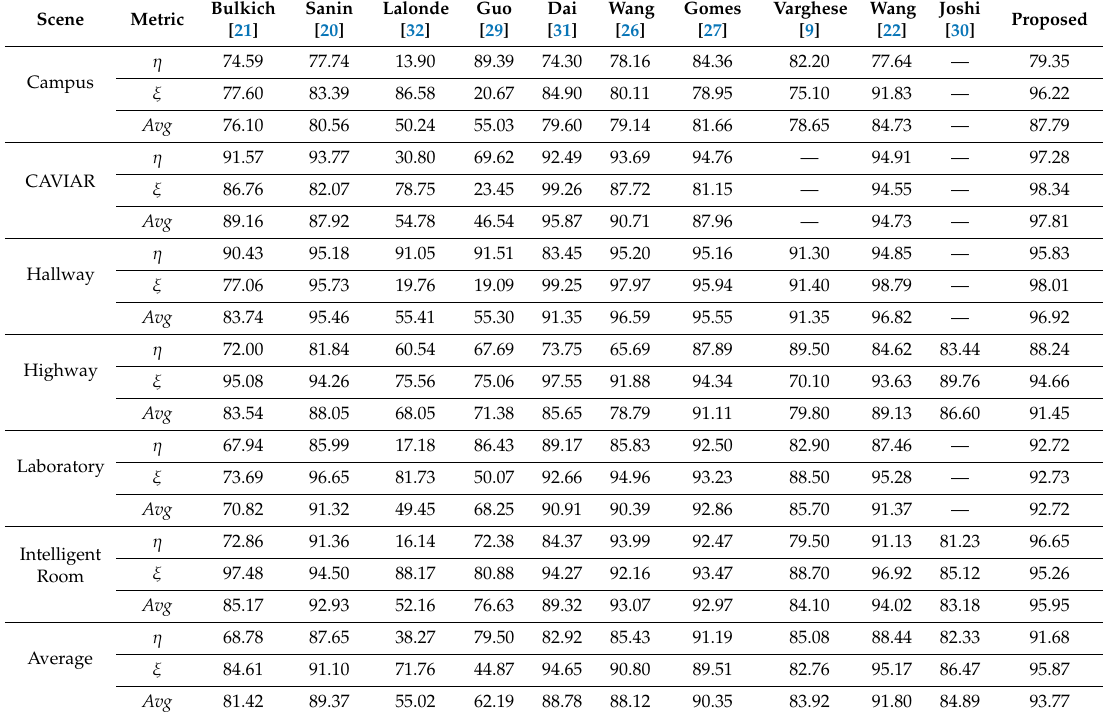
Shadow detection results of the proposed method and compared methods on the popular